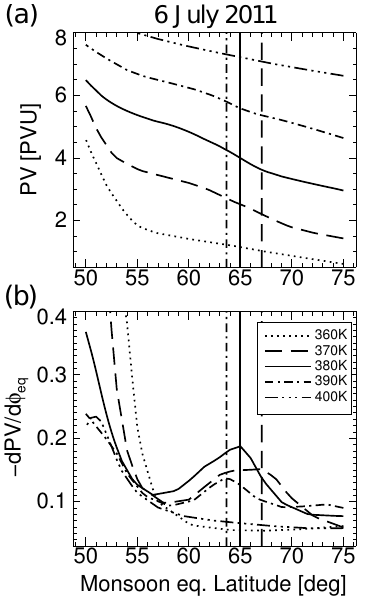
Figure 8. (a) Potential vorticity with respect to monsoon centered equivalent latitude for 6 July 2011 (calculated from the 5–7 July average), on different levels (360, 370, 380, 390, 400K isentropes). (b) The corresponding PV-gradients with respect to equivalent lati- tude. Vertical lines show the gradient maxima (transport barriers).